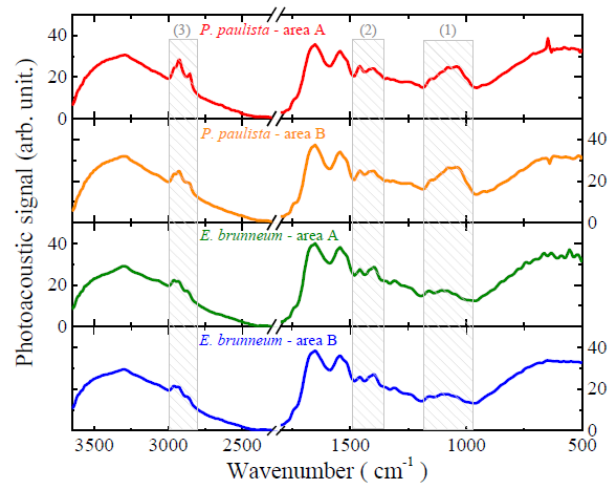
Fig 3 . Scatter plot showing the differences in venom chemical composition among Polybia paulista wasps and Ectatomma brunneum ants collected in two different areas (A and B) of Dourados-MS.